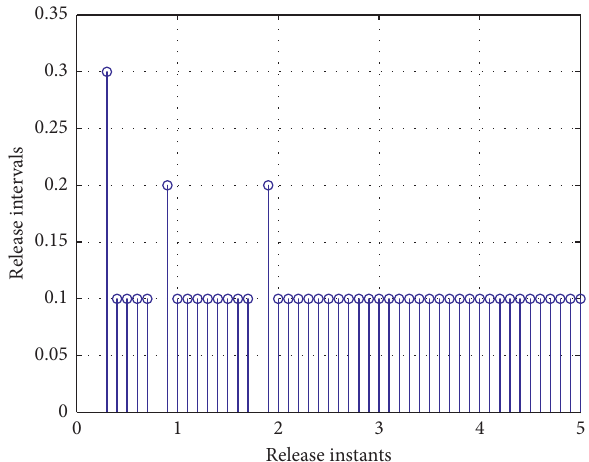
Figure 6: Release instants and intervals for Example 1 under EIC.